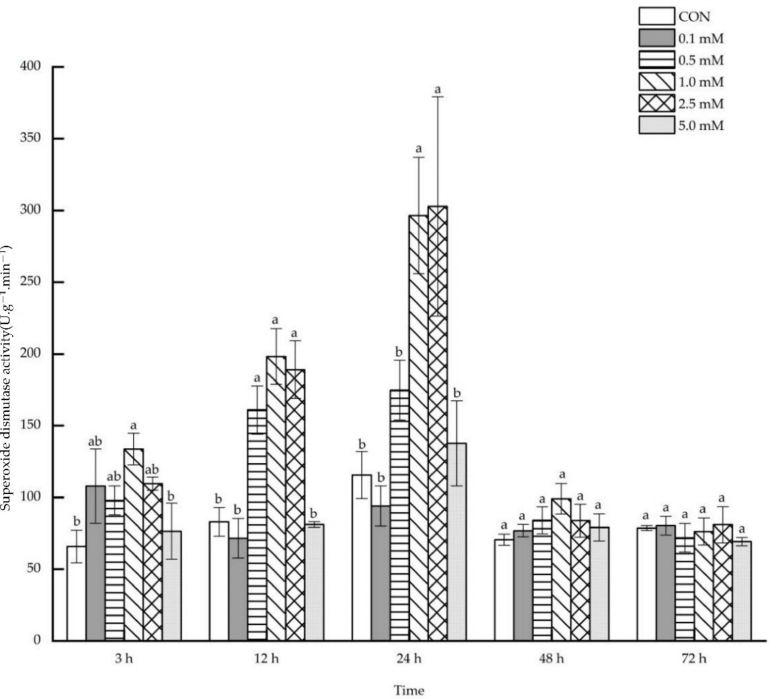
Figure 12. The systemic effect of the SA concentration and post-treatment time on the superoxide dismutase activity in roots following exogenous foliar application. The data are presented as mean ± standard errors. The significance of data was determined by the Duncan method. The difference between different letters at the same time reached significant levels of